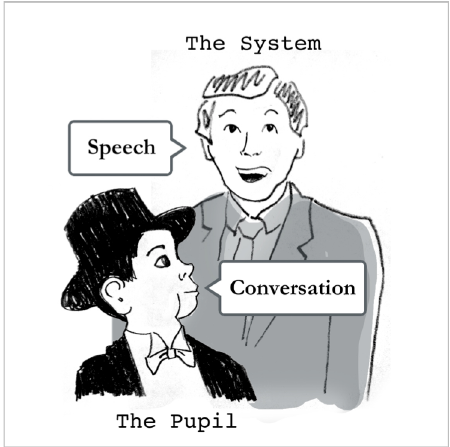
Figure 5 | Ventriloquism diagram with participant and object. Figure 6 | Ventriloquism diagram for system-pupil